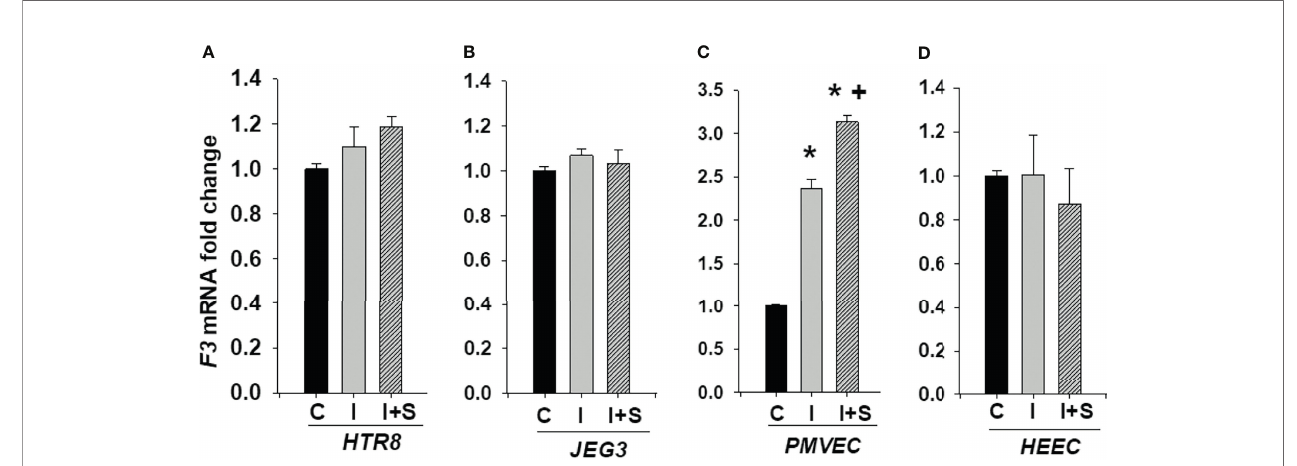
FIGURE 7 | IFN g with or without S-protein signi fi cantly increases tissue factor ( F3) levels in only PMVECs. Expression of F3 was measured in HTR8/SV neo (A) , JEG3 (B) , PMVECs (C) , and HEECs (D) treated with either control or 10 ng/ml rh-IFN g alone or in combination with 10 ng/ml rh-S-protein. Bars represent mean ± SEM, n=4 * P<0.05 vs. control. + P<0.05 vs . rh-IFN g alone. C, Control; I, rh-IFN g ; and I+S, rh-IFN g +